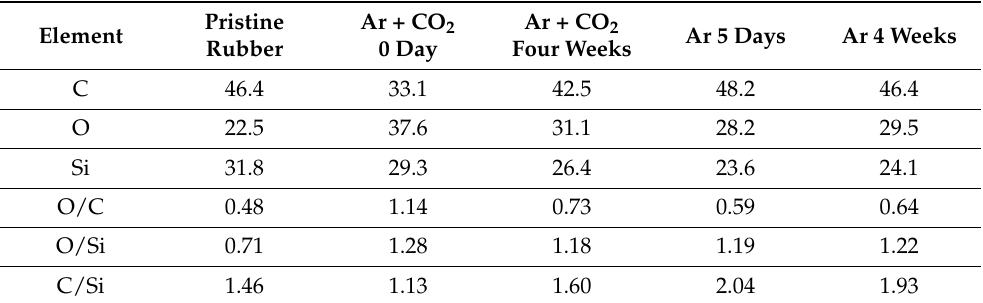
Table 4. The composition of the silicone rubber surface determined by the XPS [at%] and the ratio of